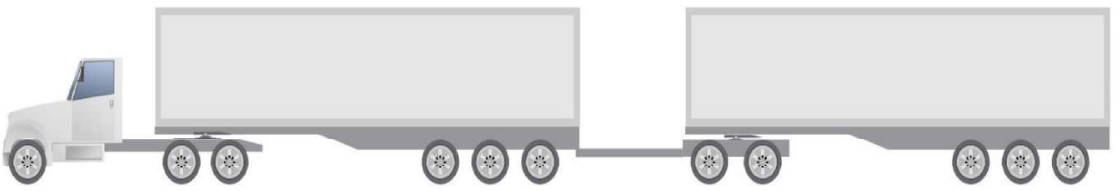
Figure 1. A 30 m, 11-axle multi-articulated vehicle.